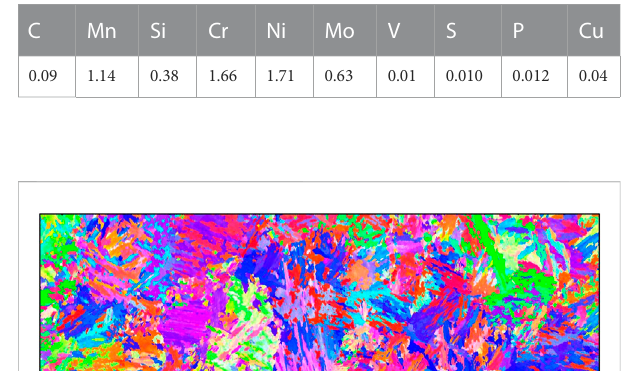
TABLE 1 Composition of the investigated weld in wt% (rest Fe).